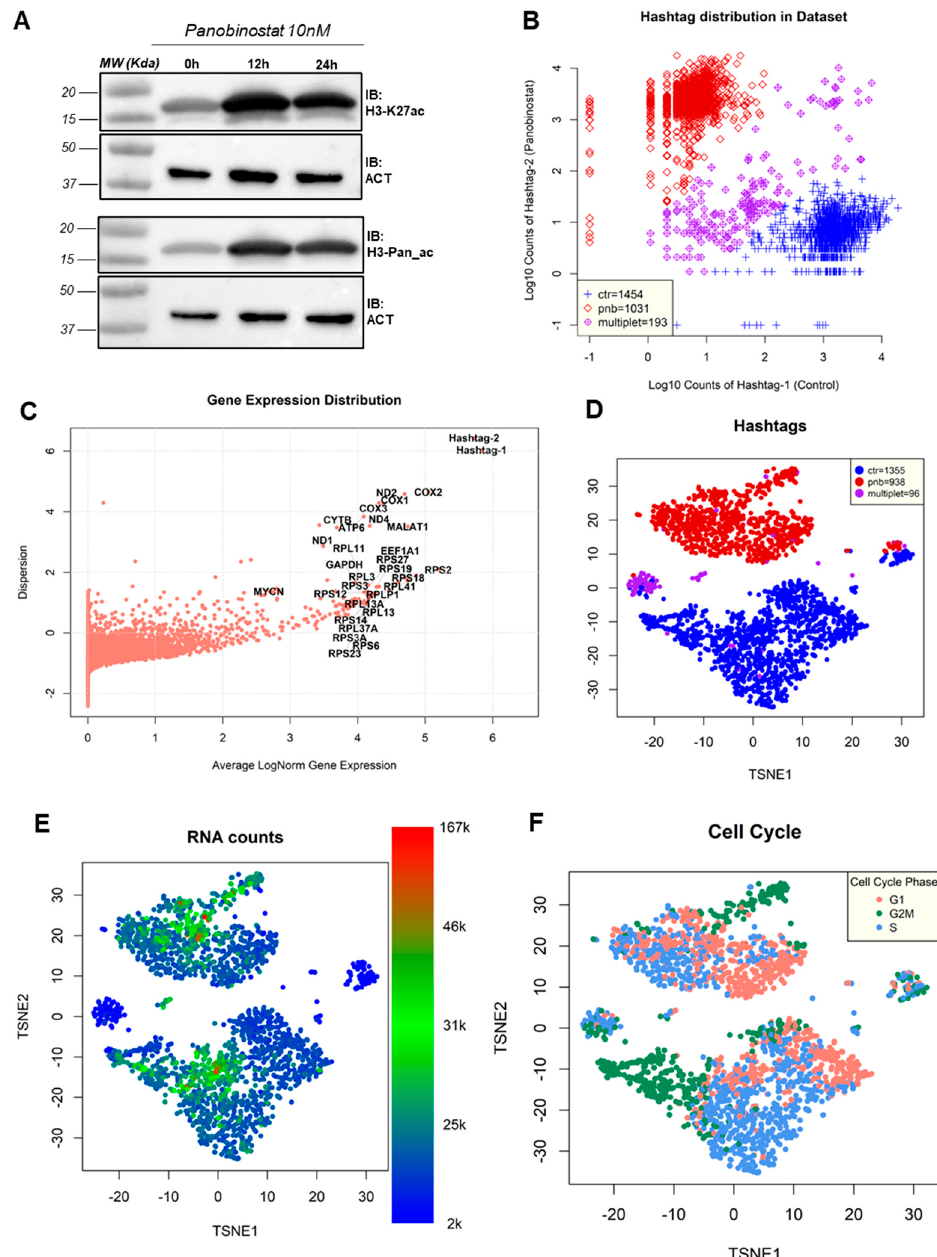
Figure 1. ( A ) Immunoblot analysis for histone H3 lysine 27 acetylation (H3-K27ac) or histone H3 pan-acetylation (H3-Pan_ac) upon treatment with 10 nM panobinostat at time points 0, 12, and 24 h; β -actin (ACT) was used as a loading control. ( B ) Distribution of Kelly cells according to hashtag expression. X-axis: hashtag 1 (associated with control cells), y-axis: hashtag 2 (associated with PNB-treated cells). The legend indicates the number of cells assigned to three groups: prevalently control (ctr), prevalently treated (pnb), and ambiguous (multiplet). ( C ) Distribution of genes in the experiment plotted by average log-normalized gene expression (x-axis) and by dispersion (y-axis). Labels are reported for genes (and hashtags) with the highest overall expression (MYCN is reported for comparison). ( D ) t-distributed stochastic neighbor embedding (t-SNE) projection of the dataset prior to removal of ambiguous hashtag cells; colors indicate the cell assignment: control (ctr), PNB-treated (pnb), and ambiguous (multiplet). ( E ) t-SNE projection, as in the previous panel, with colors indicating the number of reads detected in each cell. ( F ) t-SNE projection, as in the previous panel, with colors indicating the cell cycle phase predicted in silico according to known cell markers [42].